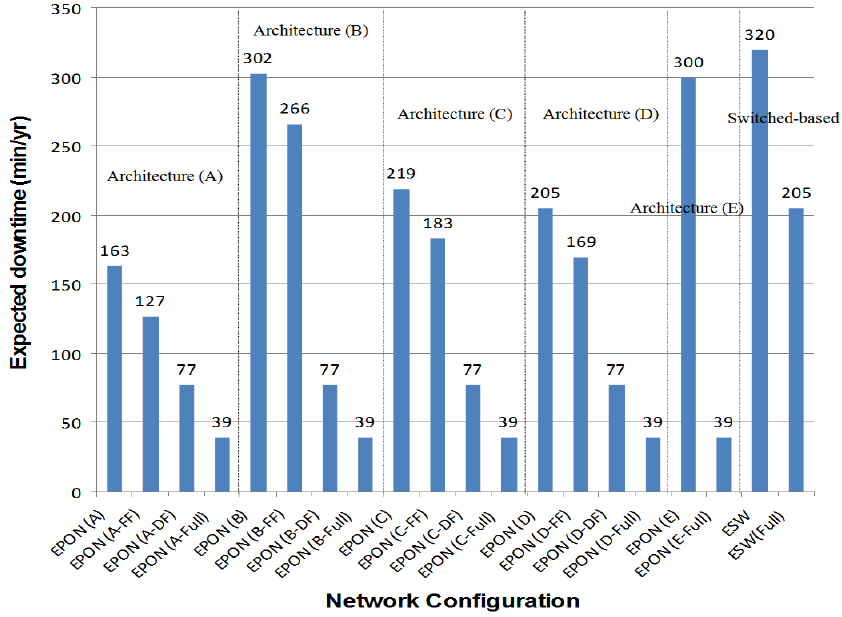
Figure 13. Mean down time for different architectures for a small (wind power farms) WPF.